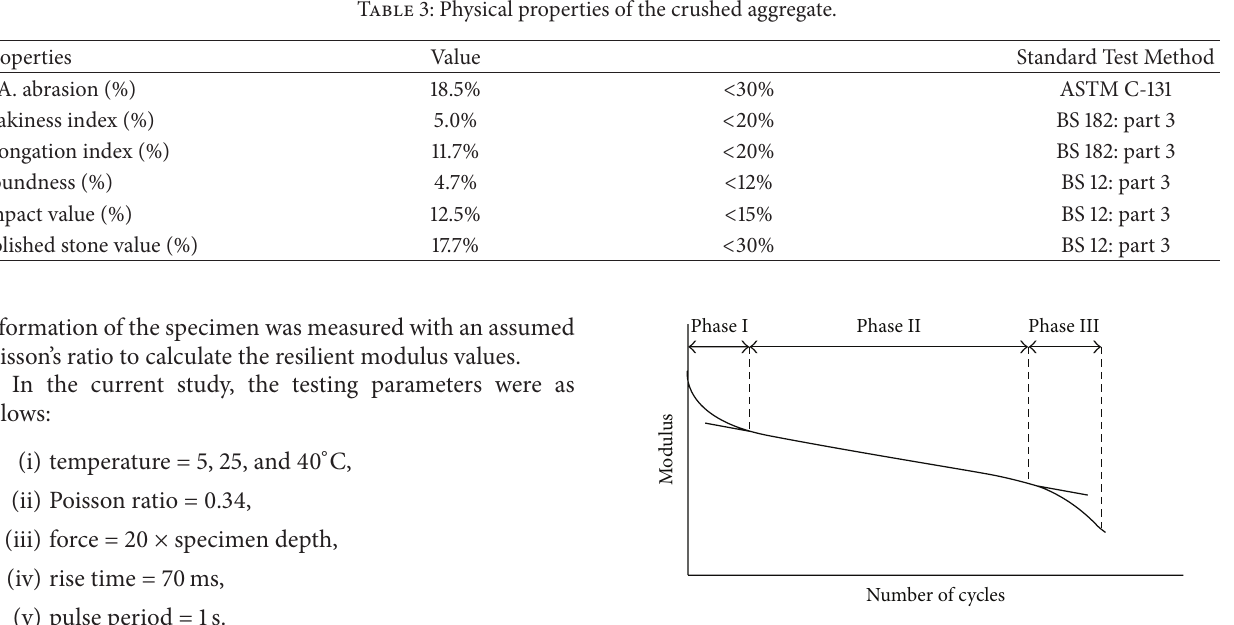
Figure 2: The three phases of fatigue test